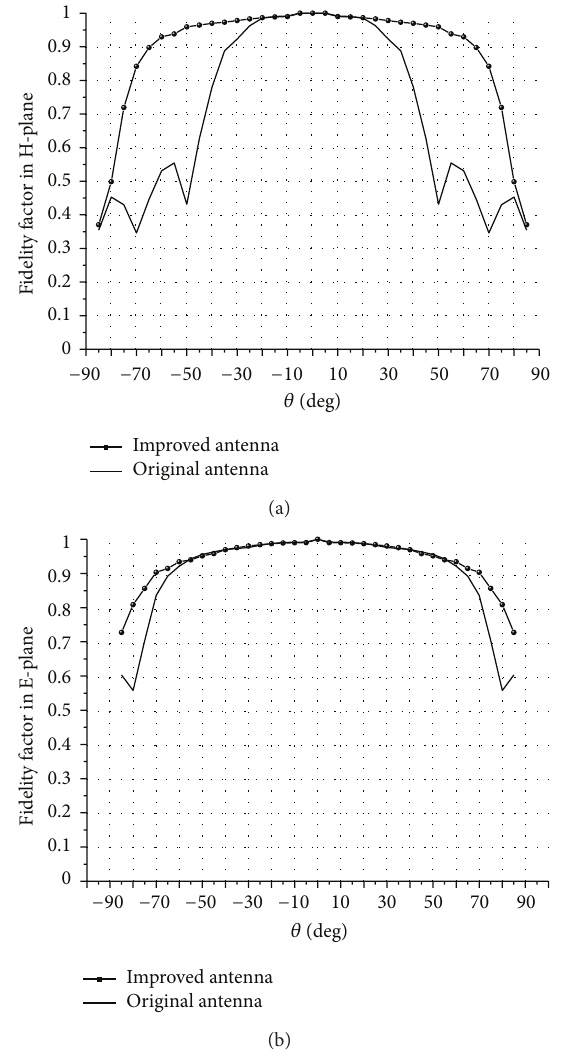
Figure 11: (a) Measurement results of fidelity factor in H-plane and (b) measurement results of fidelity factor in E-plane.